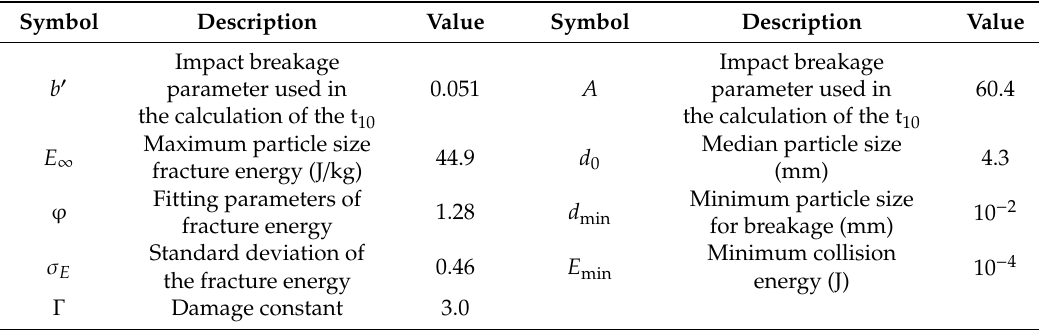
Table 1. Breakage